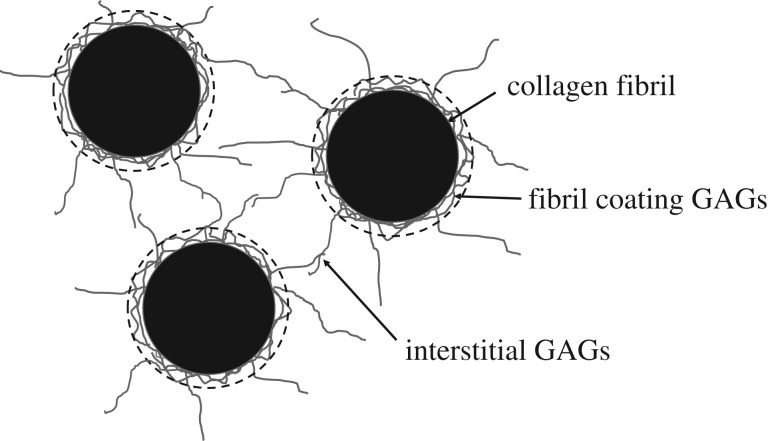
Schematic of three collagen fibrils in cross-section (black) with associated glycosaminoglycans (GAGs; grey). For the purposes of this paper, the GAGs have been divided into two components: fibril coating GAGs and interstitial GAGs. X-ray scattering measurements of fibril diameter include the cylindrical collagen fibril plus the surrounding fibril coating (shown as a broken black line).